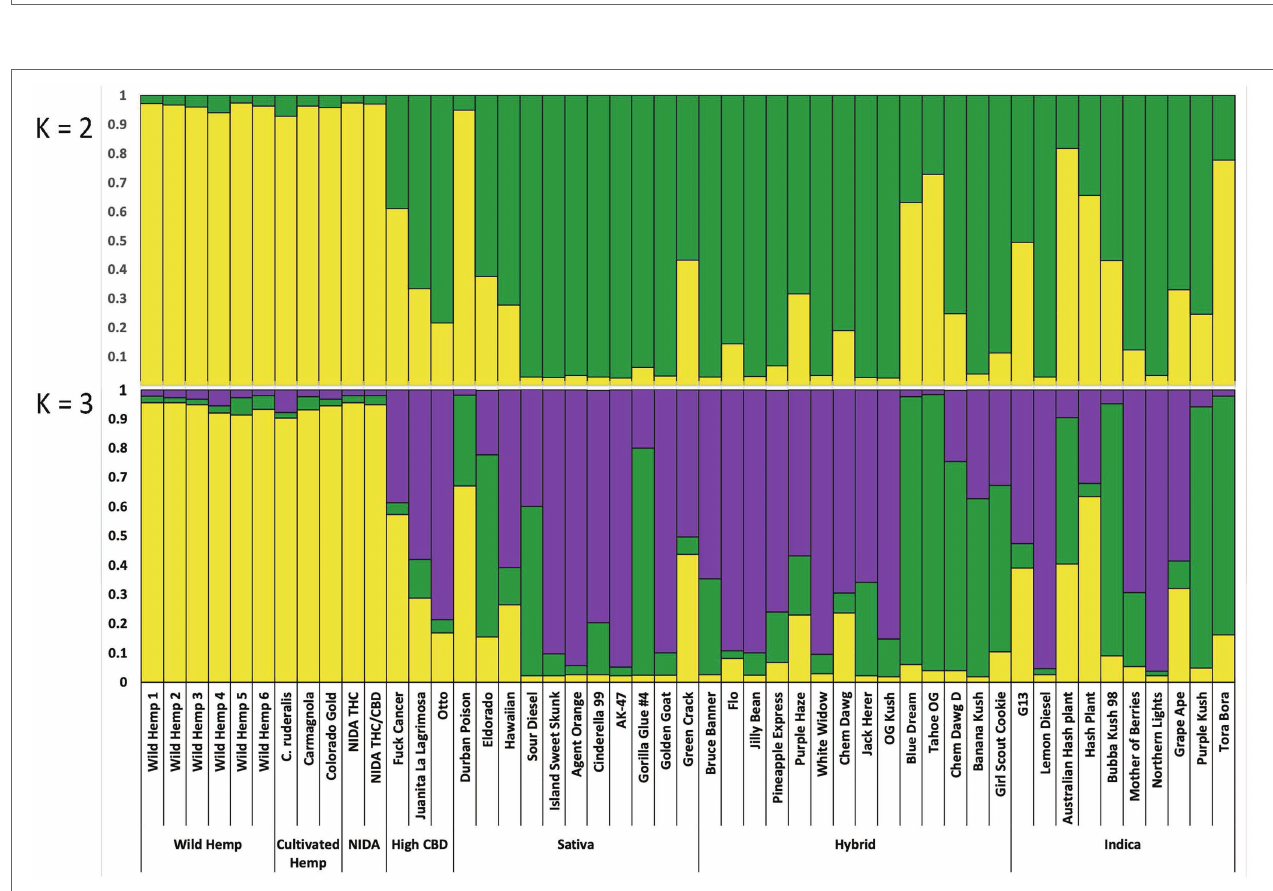
FIGURE 4 | Bayesian clustering analysis from STRUCTURE with the proportion of inferred ancestry for two genetic groups (K = 2, top), and for three genetic groups (K = 3, bottom), Each individual is represented as a single bar in the graph.